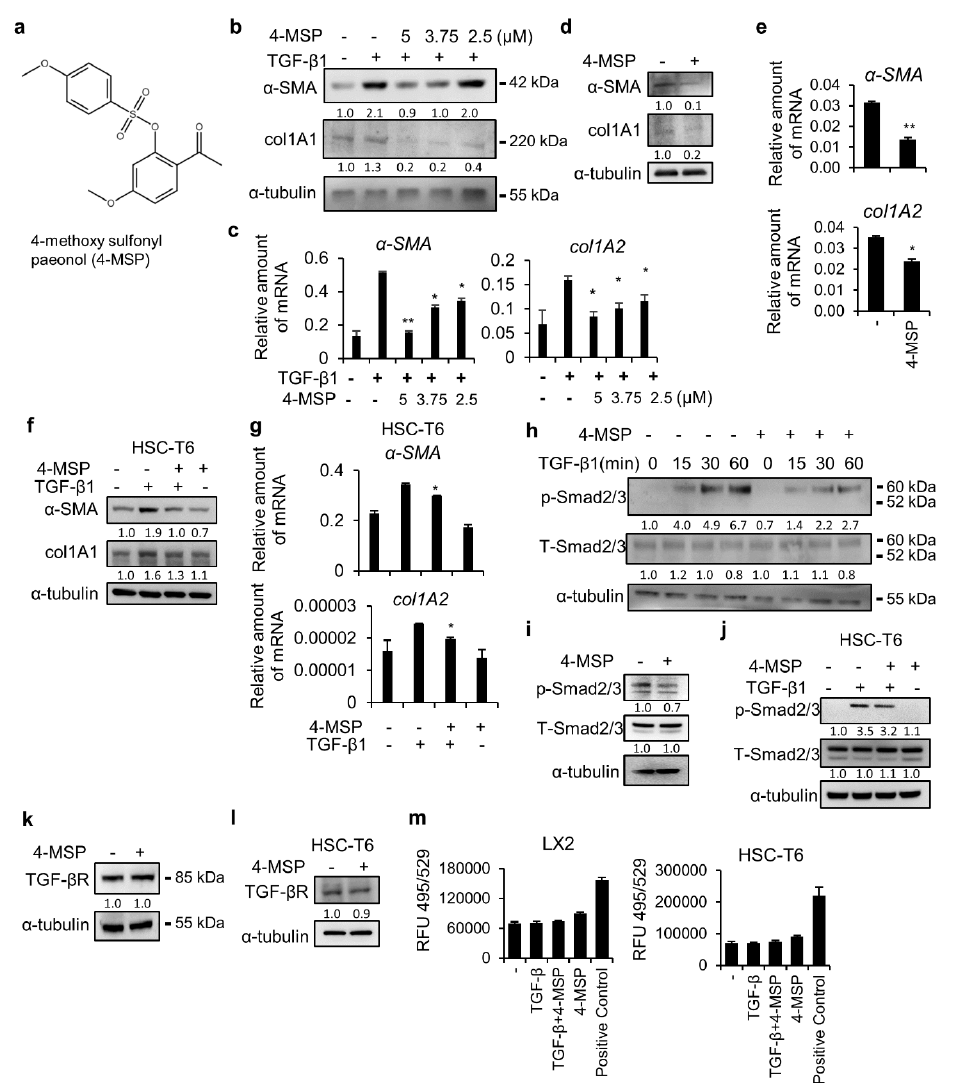
Figure 1. Compound 4-MSP inhibits TGF- β 1-induced hepatic stellate cells (HSCs) activation. ( a ) Structure of 4-methoxy sulfonyl paeonol (4-MSP). ( b ) LX2 cells were treated with TGF- β 1 (10 ng / mL) and 4-MSP for 24 h. Western blot analyzed the protein levels of α -SMA, col1A1, and α -tubulin. ( c ) Real-time PCR detected mRNA levels of α -SMA and col1A2 relative to that of GAPDH. *: p < 0.05 vs. TGF- β 1 alone group; **: p < 0.01 vs. TGF- β 1 alone group. ( d ) LX2 cells were treated with 4-MSP for 24 h. Western blot analyzed the protein levels of α -SMA, col1A1, and α -tubulin. ( e ) Real-time RT-PCR detected mRNA levels of α -SMA and col1A2 relative to that of GAPDH. *: p < 0.05 vs. control group; **: p < 0.01 vs. control group. ( f ) HSC-T6 cells were treated with TGF- β 1 (10 ng / mL) and 4-MSP for 24 h. Western blot analyzed the protein levels of α -SMA, col1A1, and α -tubulin. ( g ) Real-time RT-PCR detected mRNA levels of α -SMA and col1A2 relative to that of GAPDH. *: p < 0.05 vs. TGF- β 1 alone group. ( h ) Pre-treated LX2 cells with 5 µ M of 4-MSP overnight and then subjected to TGF- β 1 (10 ng / mL) for indicated times. Phosphorylation- and total-Smad2 / 3 were analyzed by western blot. ( i ) LX2 cells were treated with 4-MSP for 24 h. Phosphorylation- and total-Smad2 / 3 were analyzed by western blot. ( j ) Pre-treated HSC-T6 cells with 5 µ M of 4-MSP overnight and then subjected to TGF- β 1 (10 ng / mL) for 30 min. Phosphor- and total-Smad2 / 3 were analyzed by western blot. ( k ) LX2 cells were treated with 4-MSP for 24 h. Western blot analyzed the protein levels of TGF- β R and α -tubulin. ( l ) HSC-T6 cells were treated with 4-MSP for 24 h. Western blot analyzed the protein levels of TGF- β R and α -tubulin. ( m ) Cellular reactive oxygen species (ROS) levels were performed by using the commercial ROS detection assay kit, according to the manufacturer’s instructions. Data are presented for three independent experiments, with similar